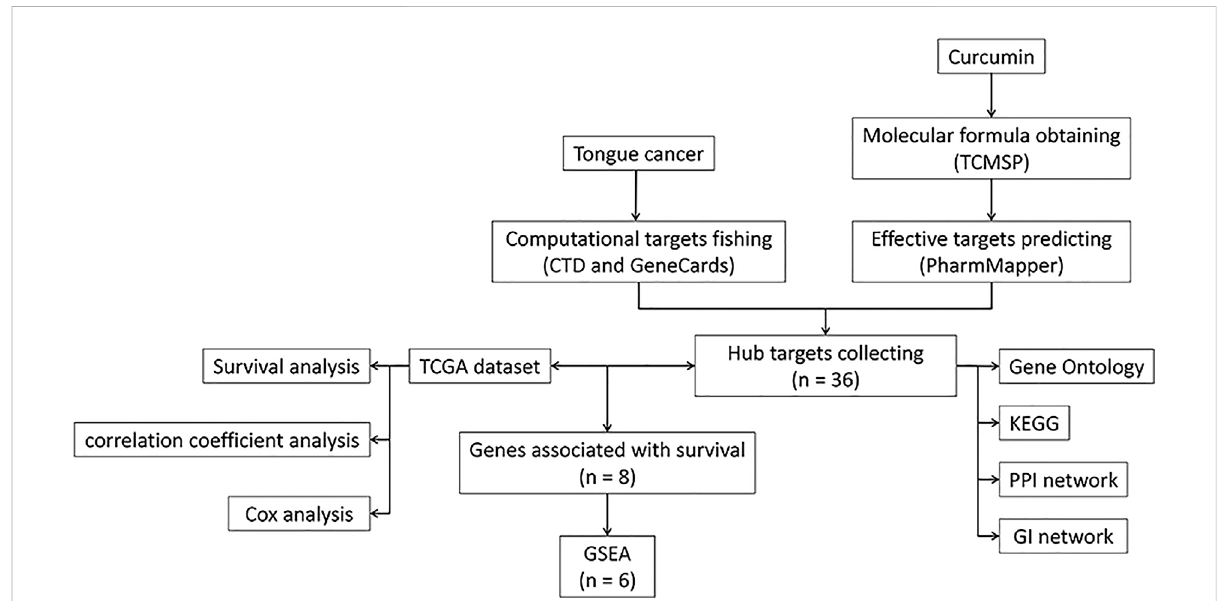
FIGURE 1 Awork fl owdiagram.TCMSP,TraditionalChineseMedicineSystemsPharmacologyDatabase,andAnalysisPlatform;KEGG,Kyotoencyclopedia of genes and genomes; PPI, Protein-Protein Interaction; GI, Genetic Interaction; TCGA, The Cancer Genome Atlas; GSEA, Gene Set Enrichment